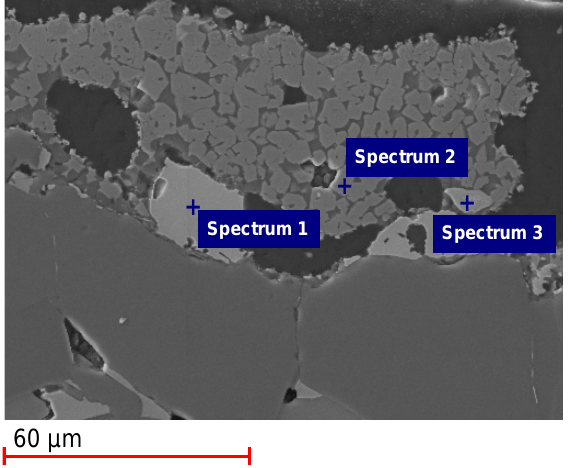
Figure 3. SEM image and EDS spectra of Monolith 2 after 1 cycle.